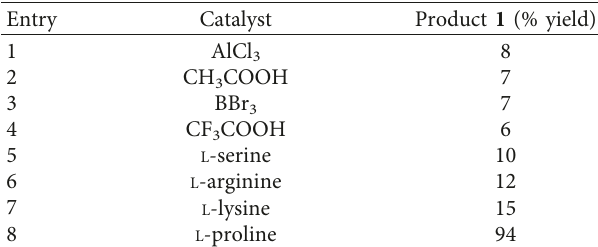
Table 1: Product percentage under various catalysts of synthesis of